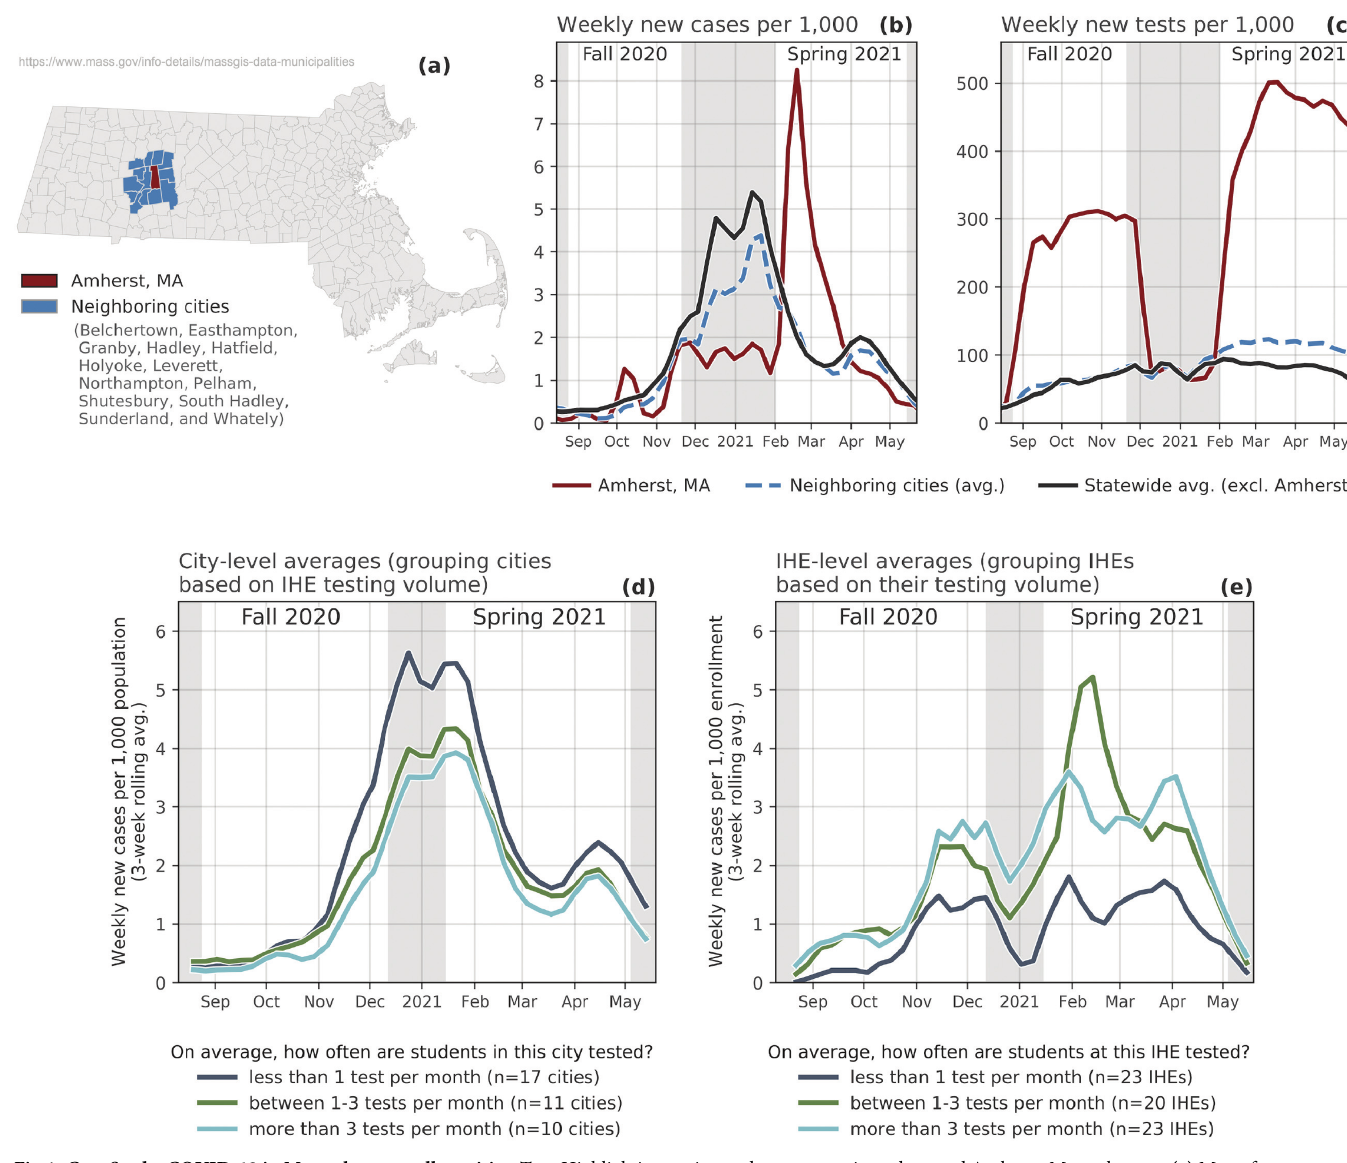
Fig 4. Case Study: COVID-19 in Massachusetts college cities. Top: Highlighting testing and case counts in and around Amherst, Massachusetts. (a) Map of Massachusetts cities; in this map, the city of Amherst is red and the surrounding cities are colored blue. (b) Time series of weekly new cases per 1,000 in: Amherst, the surrounding cities, and the rest of Massachusetts. (c) Time series of weekly new tests per 1,000 in: Amherst, the surrounding cities, and the rest of Massachusetts. Bottom: Comparing outcomes of cities and IHEs with more/less IHE-affiliated testing. (d) City-level average weekly new cases per 1,000, grouped by cities with IHEs that test students on average fewer than once a month, between one and three times a month, and over three times a month (Note: we sought out city-level data for COVID-19 deaths, but the state does not report these). (e) IHE-level average weekly new cases, grouped by IHEs that test students on average fewer than once a month, between one and three times a month, and over three times a month. Municipality boundary map downloaded from MassGIS (Bureau of Geographic Information) [58].